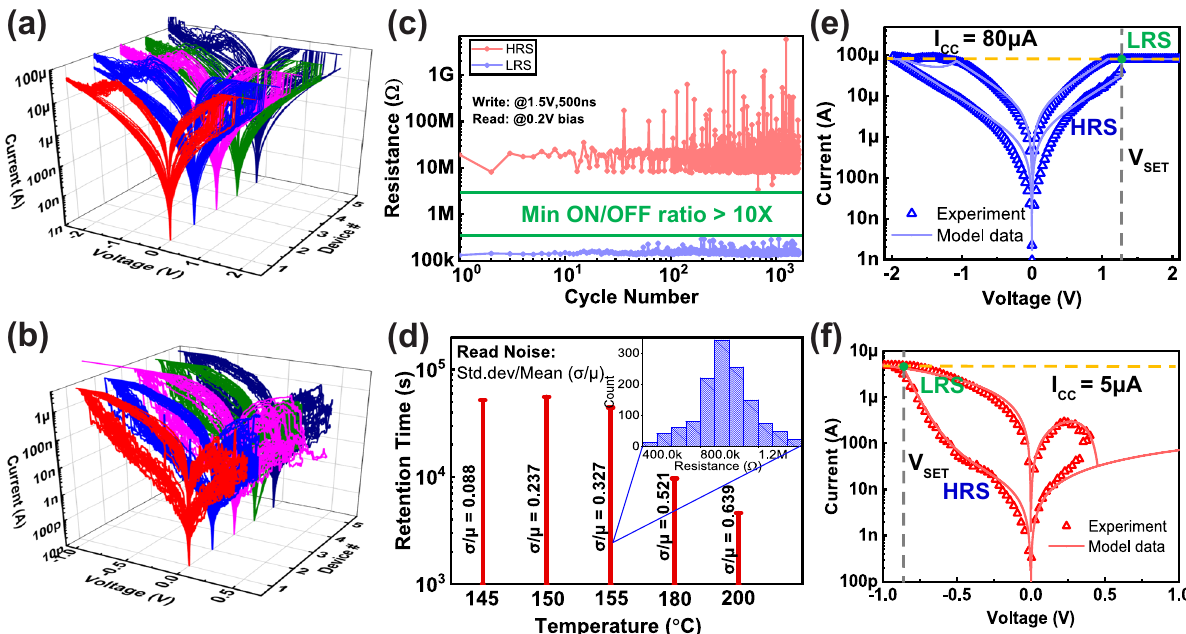
Fig. 3 The study and modeling of the devices ’ responses. a, b Spatial DC curves from randomly selected a Pt-RRAM and b Gr-RRAM devices. All the measured devices exhibit similar behavior for multiple cycles. c Endurance pulse test of the Gr-RRAM device, where the minimum detected ON/OFF ratio is greater than 10×. d Retention time results of Gr-RRAM before unintended resistance shift occurs under reading voltage (0.1 V bias) and various thermal stresses ranging from ~145 to 200 °C. The read noise at different temperatures is retrieved, where the measurement of the RRAM resistance state showed strong fl uctuations in elevated temperature environments. Inset: Resistance distribution example under 155 °C thermal stress prior to the unintended shift. e , f Experimental mean and simulated Verilog-A model switching characteristics for e Pt-RRAM with 80 μ A switching current ( I W ), and f Gr-RRAM with I W = 5 μ A.